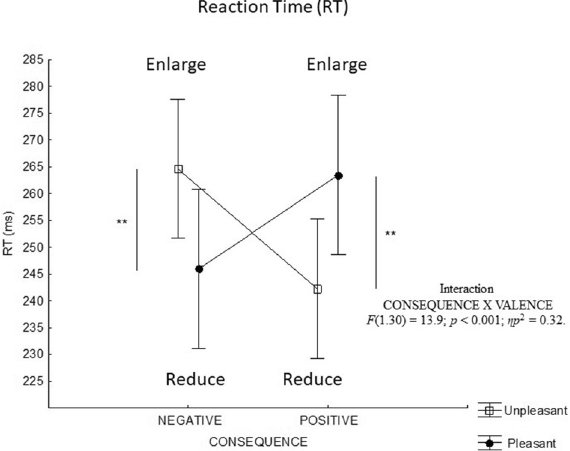
Figure 1. Test sequence and setup for the left-pointing movement: (a) Representation of the experimental procedure. The symbol + (or −) indicates enlargement or reduction, respectively. The click on the symbol triggers the occurrence of an emotional picture (nontarget) and the target after 150 ms. The click on the target triggers the enlargement or reduction of the picture for 3 s. (b) Typical stylus velocity profile allowing the determination of the temporal parameters of the pointing. (c) Typical trajectory of the stylus allowing us to determine the spatial parameters of the pointing.